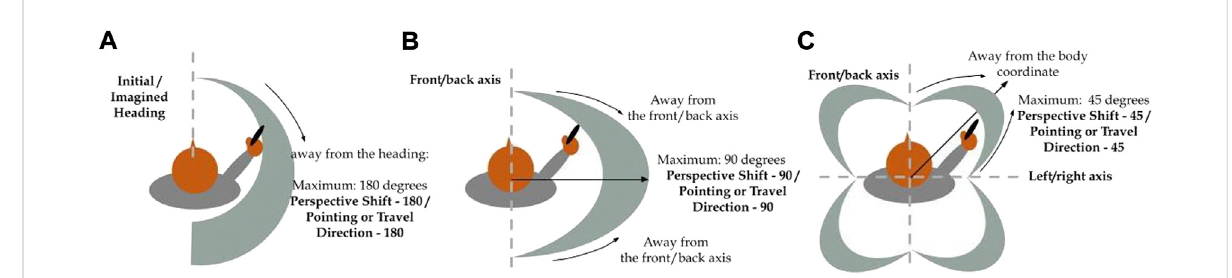
FIGURE 2 Illustrations of the three different reference frames that might affect the relative dif fi culty across trials (A) front (initial heading), (B) front/back axis or (C) both the front/back and left/right axes. Maximum errors are expected when furthest from the reference axis. Thus, when using just the initial heading direction for reference (A) ,maximumerrorsare expected at180 ° . Whenusing thefront/back axis (B) , maximum errorsare expectedat 90 ° . When using both the front/back and left/right axes (C) , maximum errors are expected at 45 °